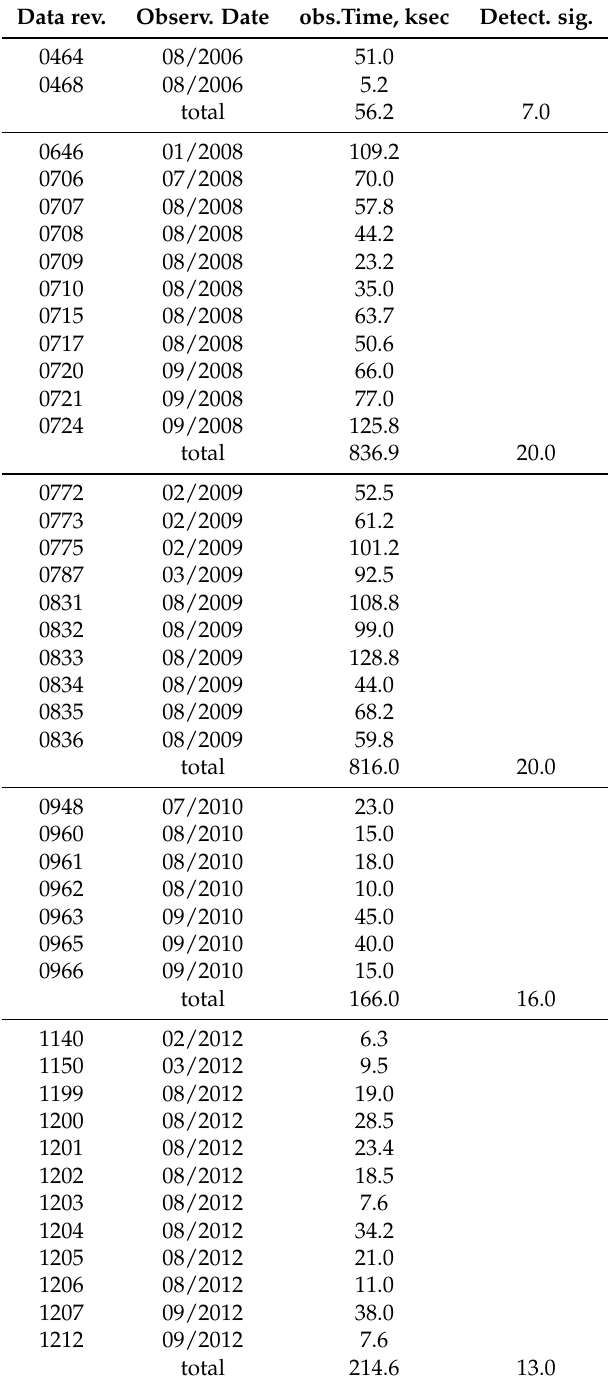
Table A4. INTEGRAL/ISGRI observations